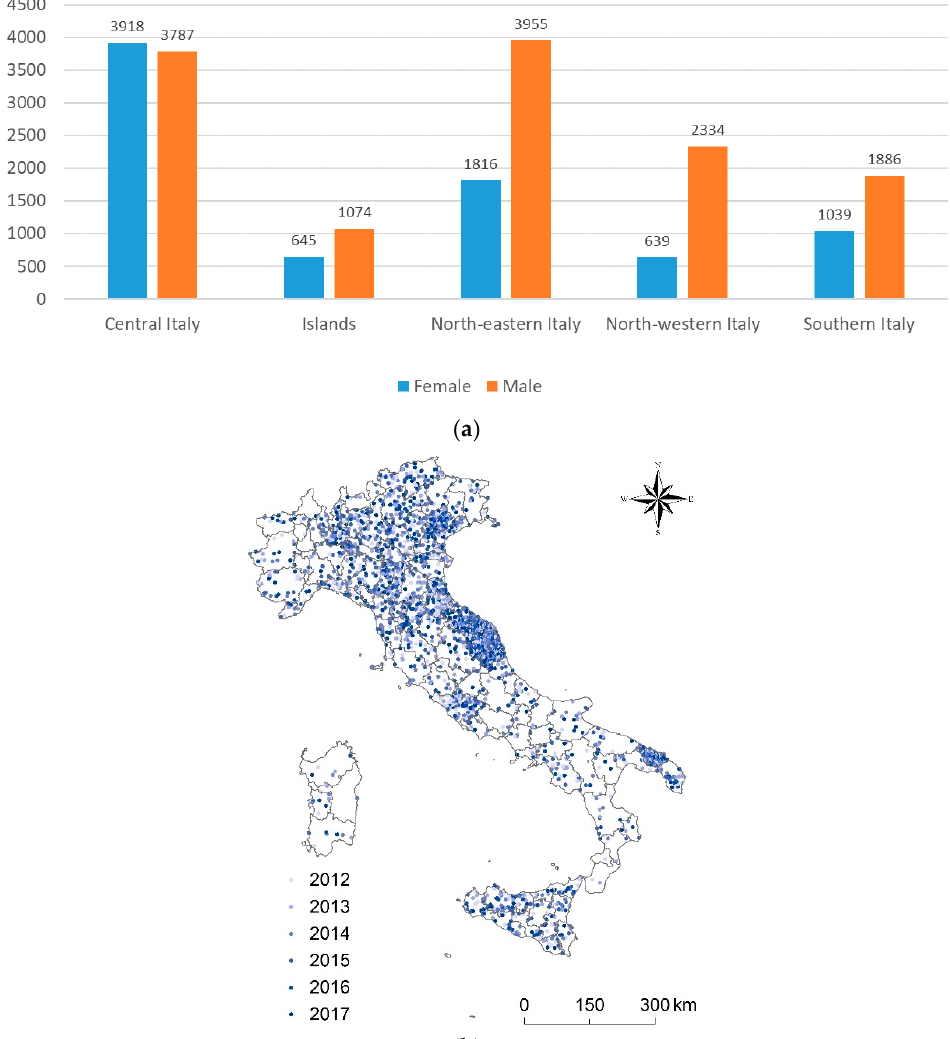
Figure 2. People (males in blue and females in orange) involved in accidents by geographical subdivision ( a ) and distribution of accidents occurred in Italy; ( b ) by year (from 2012 to 2017).